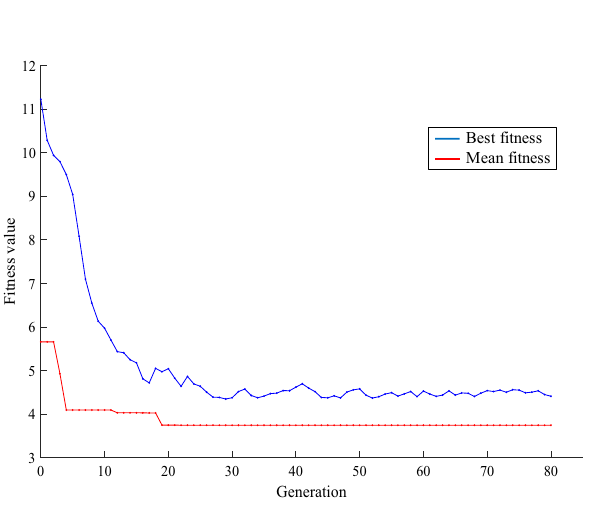
Table 7. specifications of optimized three-layer shield.